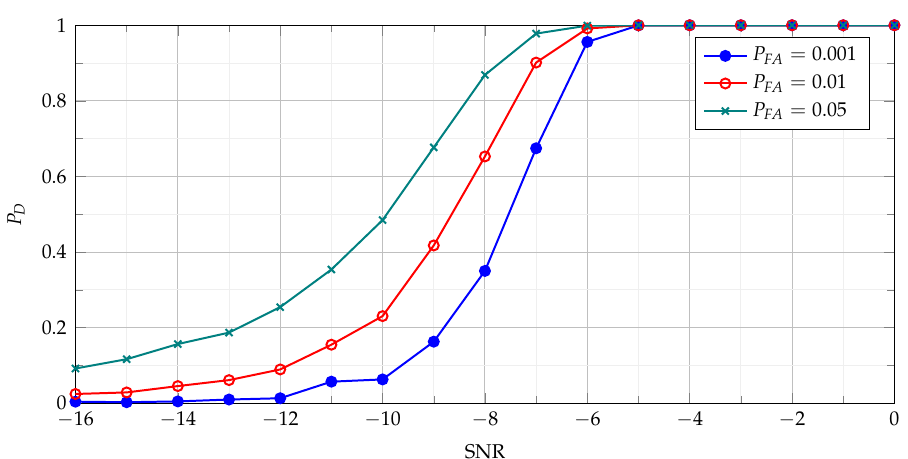
Figure 18. Probability of detection with use of the TSCPF statistics employing slices n = for N = 255.